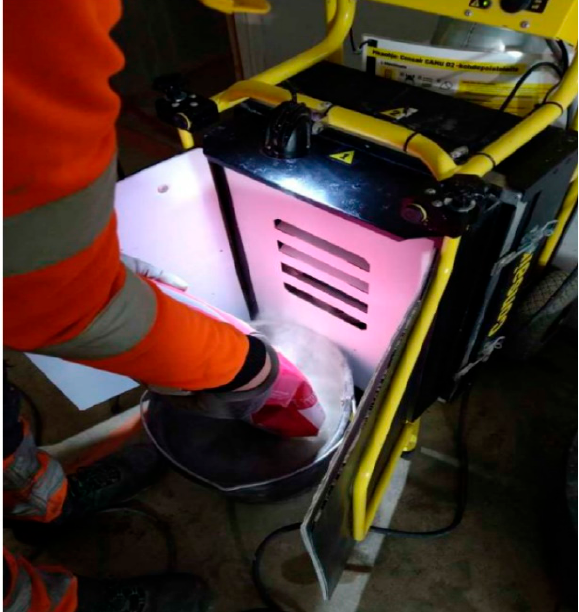
Figure 1. Using a mobile air cleaner to lower dust exhausts to general air from a hand-held jackhammer with a blade. Reproduced with permission from Tuomi et al., Finnish Institute of Occupational Health, 2022 [34].